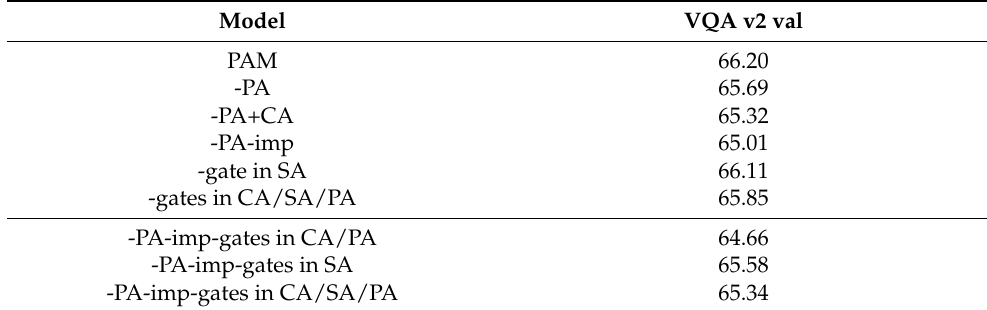
Table 3. Ablation studies of our proposed actions on the VQA2.0 validation dataset. “-” is the operation to delete trick based on complete model